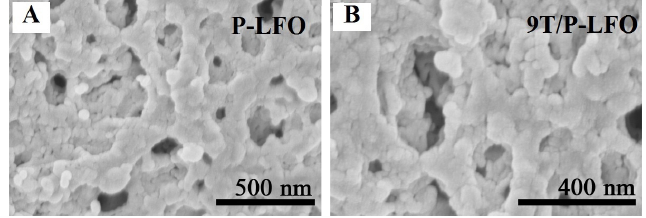
Figure 2. Scanning electron microscopy (SEM) micrograph of P-LFO ( A ) and 9T/P-LFO nanocomposite ( B ).